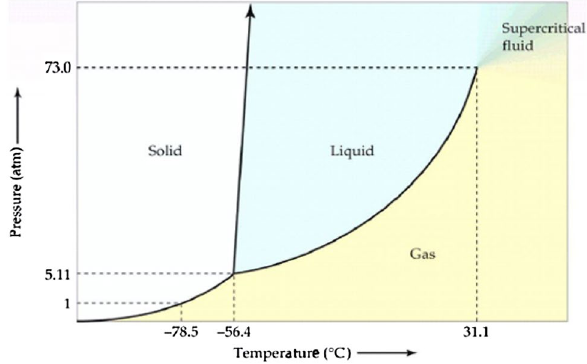
Fig. 1 Carbon dioxide (CO 2 ) pressure–temperature phase